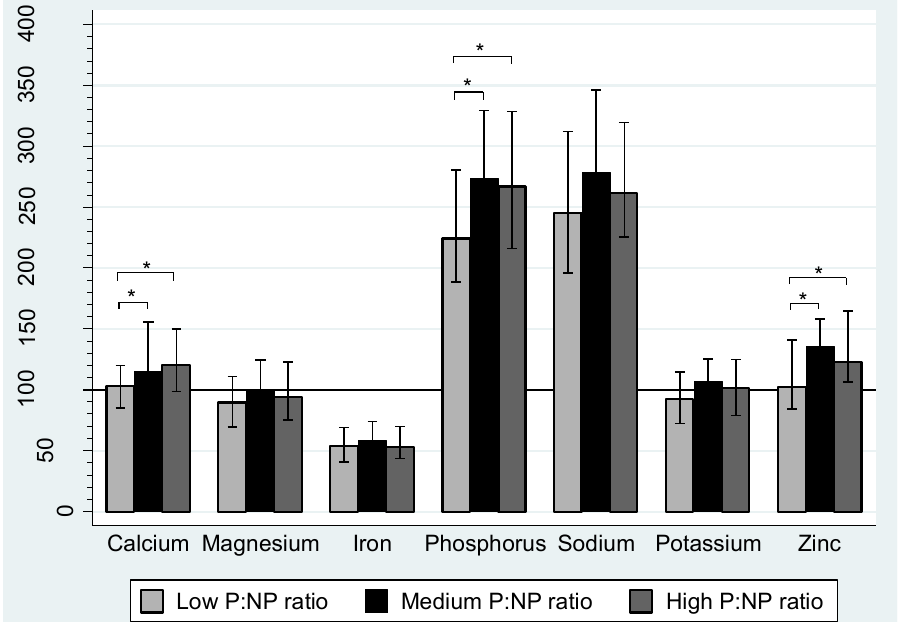
Figure 2. The percentage of Australian Nutrient Reference Value (NRV) recommendations for minerals that were achieved during pregnancy by women in the WATCH Study who reported plausible dietary data ( n = 149) by tertile of the protein to non-protein (P:NP) ratio. Plausible data is defined as energy intakes ≥4.5 and ≤20.0 MJ/d. The proportion of protein (%E) to carbohydrate (%E) and fat (%E) was used to create P:NP tertiles. The P:NP ratio for each tertile: Low P:NP ratio group 0.21 (0.19, 0.22), n = 50; Medium P:NP ratio group 0.24 (0.23, 0.25), n = 50; high P:NP ratio group 0.28 (0.27, 0.30), n = 49. Nutrient Reference Values recommended for pregnancy: Calcium = 840 mg, Magnesium = 290 mg, Iron = 22 mg, Phosphorus = 580 mg, Sodium = 920 mg, Potassium = 2800 mg, Zinc = 9 mg [30]. * P < 0.01; IQR: interquartile range.